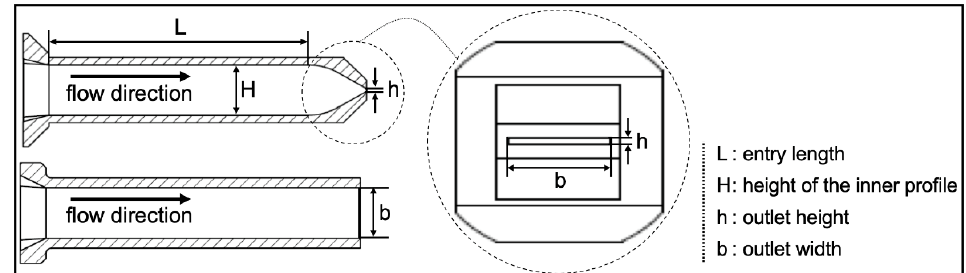
Figure 4. Parameter of the nozzle design.